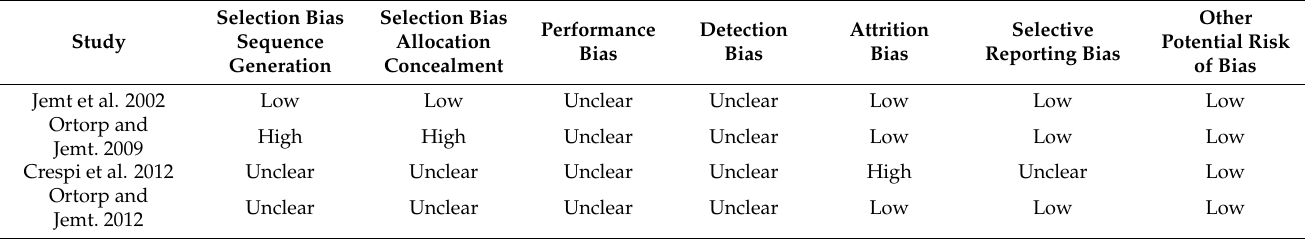
Table 2. Risk of bias for the randomized clinical trials included in the present systematic review according to Cochrane Handbook for Systematic Reviews of Interventions.